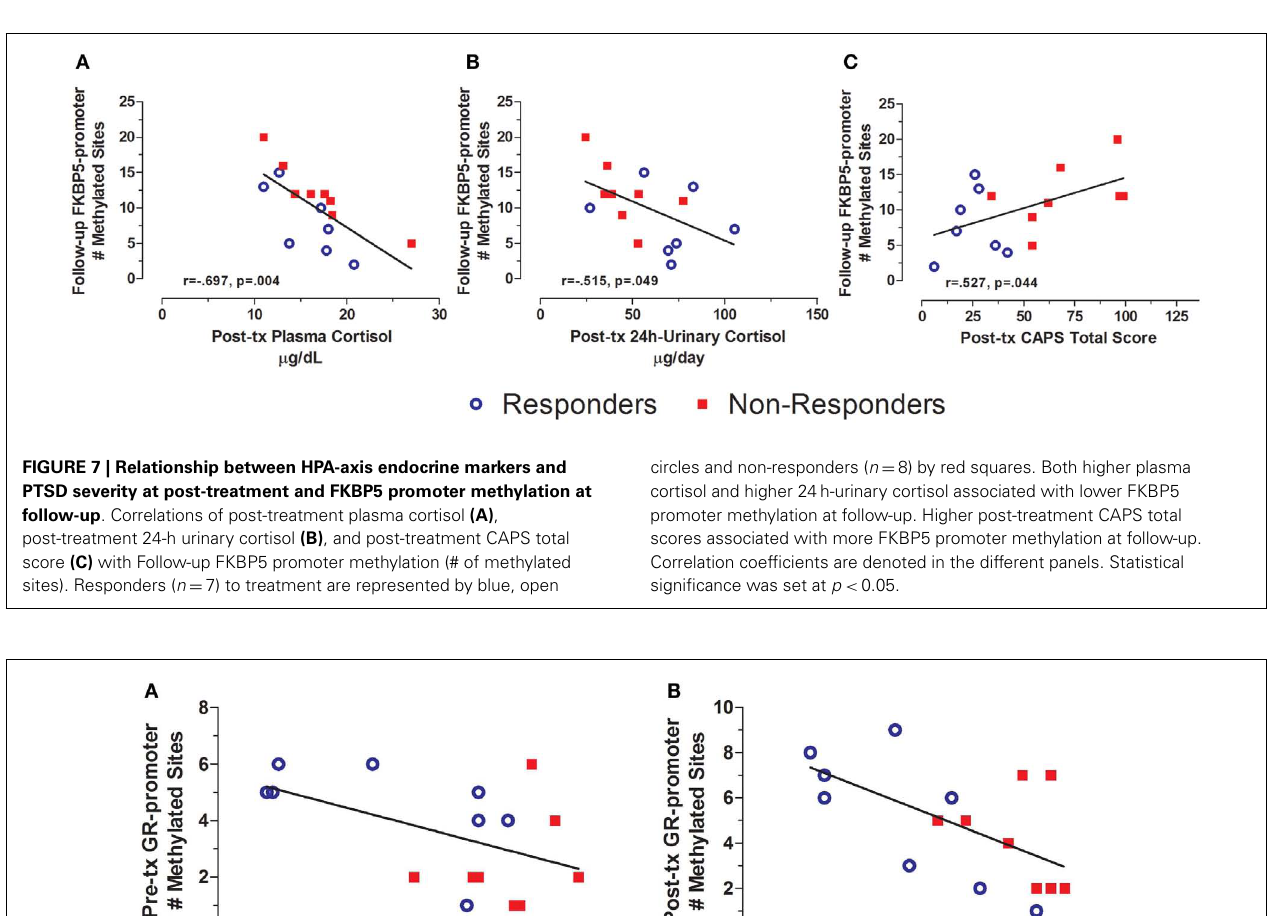
FIGURE 8 | Relationship between significant and potentially traumatic events at pre-treatment and GR exon 1F promoter methylation . Correlations of time since first trauma assessed on the Deployment Risk and Resiliency Inventory (DRRI) with the with Pre-treatment GR exon 1F promoter methylation (A) and number of life events as assessed on the DRRI with GR exon 1F promoter methylation at post-treatment (B) .